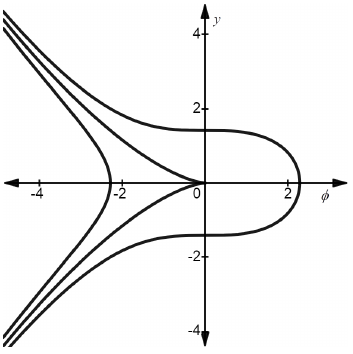
Figure 3. The phase portrait of the system (4) when v = 1, β = 1, γ = 1, and α =